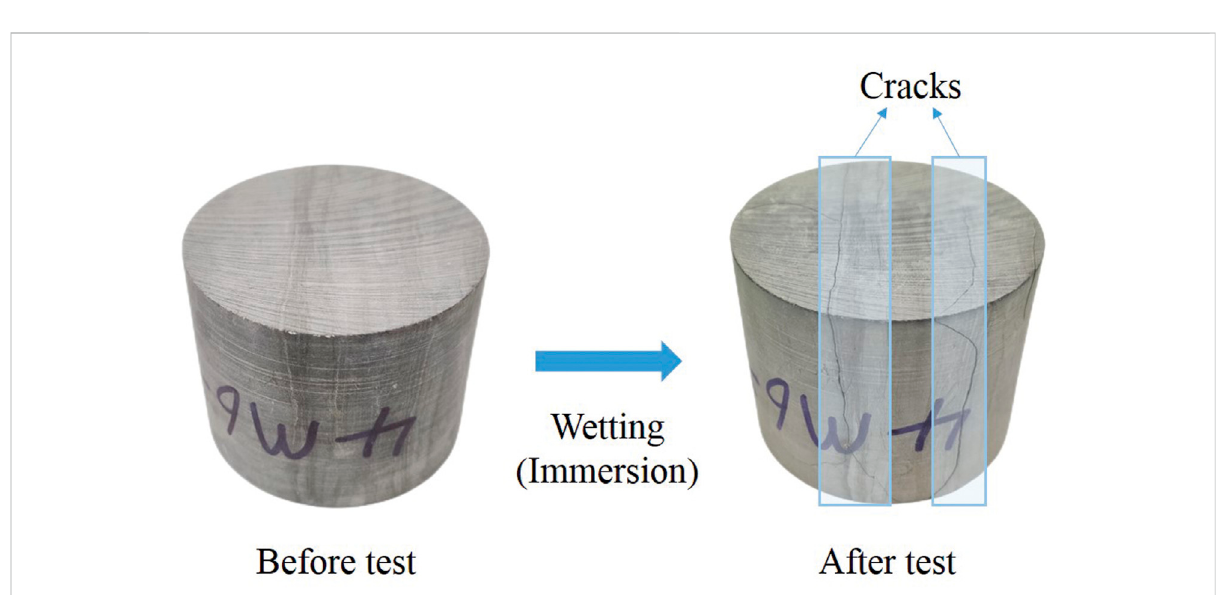
FIGURE 5 Comparison of samples with vertical interlayer before and after wetting and deterioration.